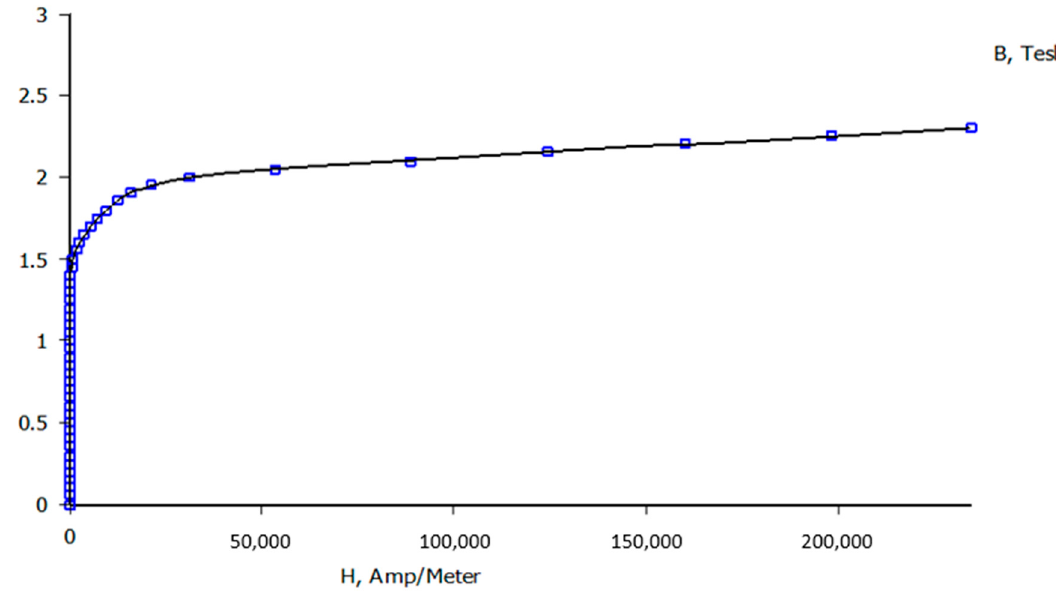
Figure 4. Magnetization curve of M-15 steel.